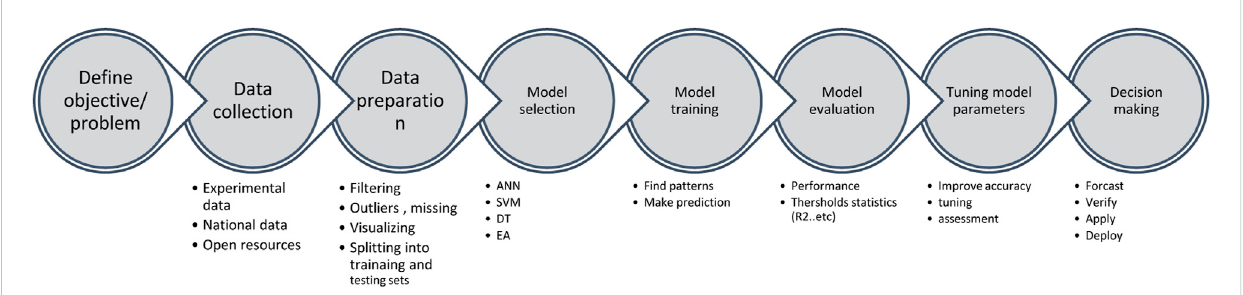
FIGURE 1 General steps in ML model development (Reich, 1997; Bonaccorso, 2017; Lehr and Ohm,